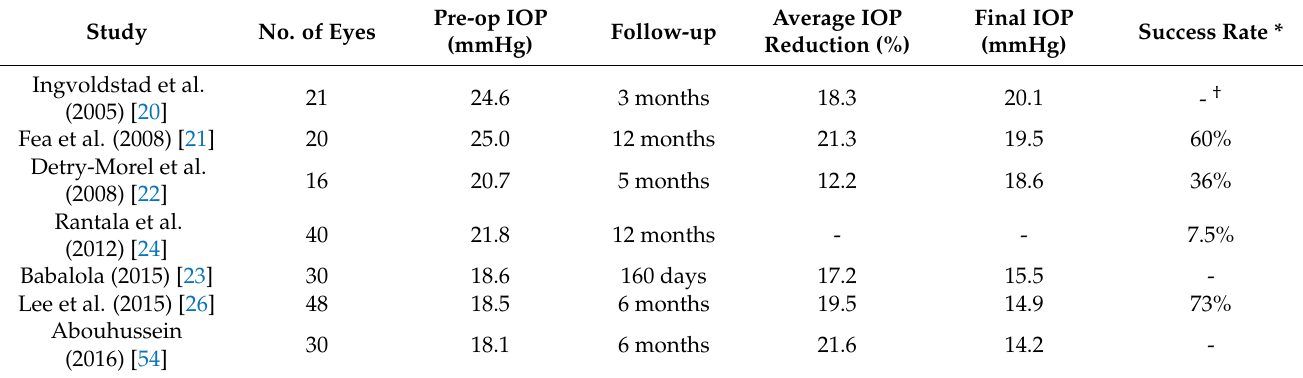
Table 2. MDLT results in different studies. IOP = Intra-Ocular